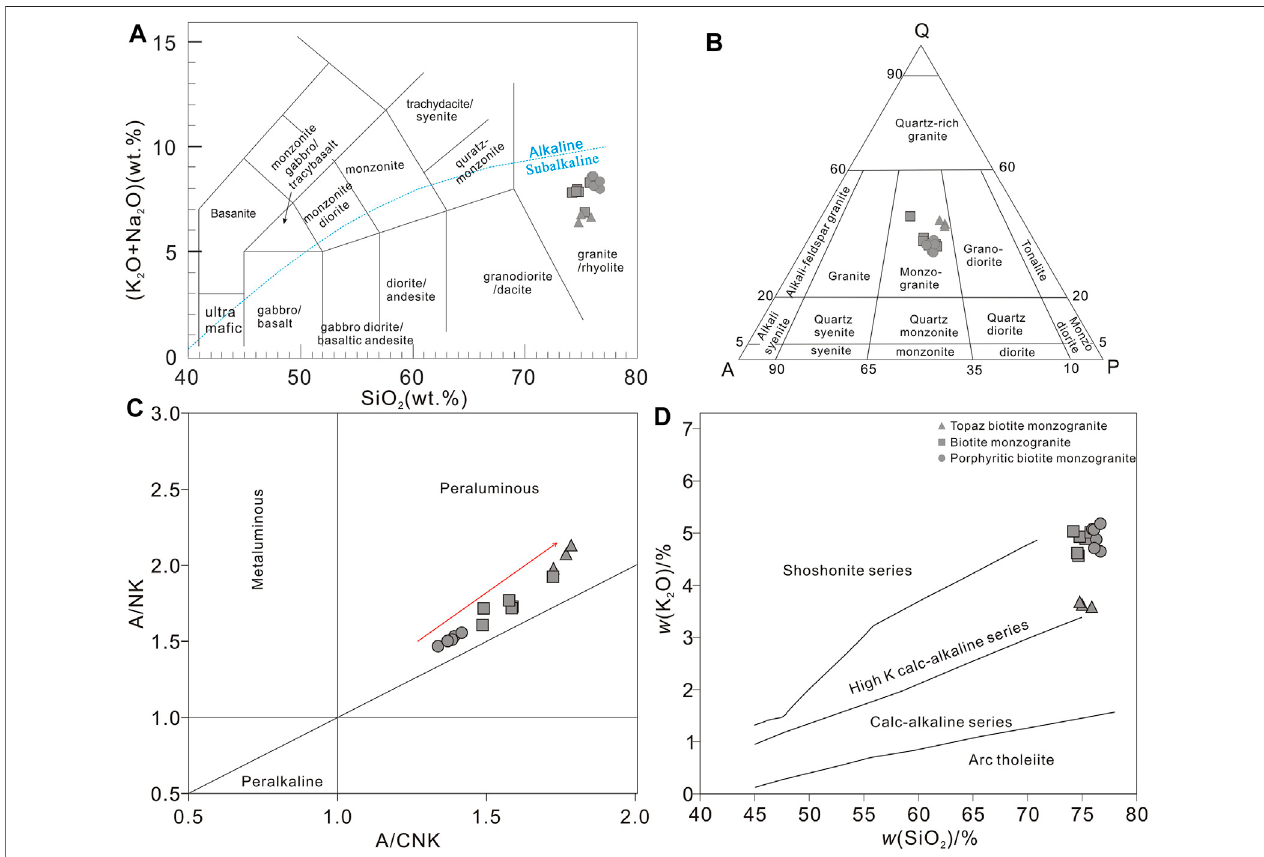
FIGURE 5 | Geochemical discrimination diagrams for the Jianfengling granitic rocks: (A) SiO 2 vs. (K 2 O + Na 2 O) (after Le Maitre, 1989); (B) QAP (after Streckeisen andLeMaitre,1979); (C) A/KNCvsA/NK,whereA/KNC=molarAl